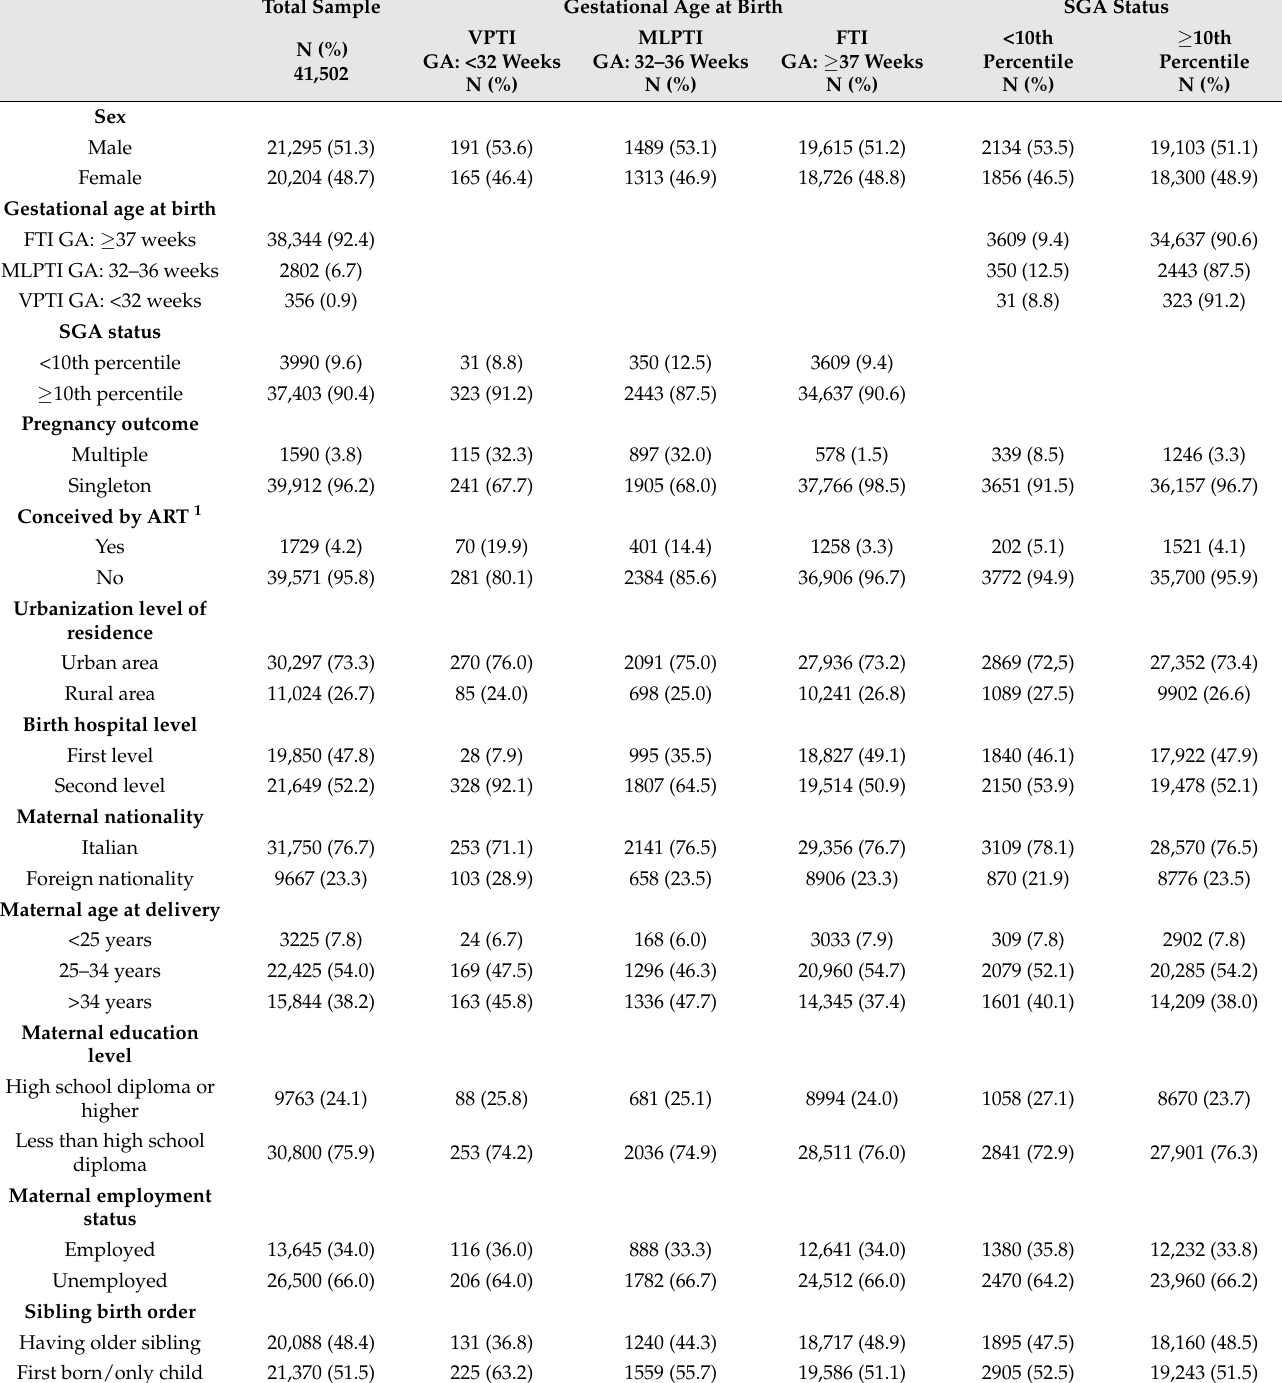
Table 1. Characteristics of the study population for the total sample: prematurity classes (very preterm infants—VPTI; moderate and late preterm infants—MLPTI; full-term infants—FTI) and SGA status at birth (<10th percentile; ≥ 10th